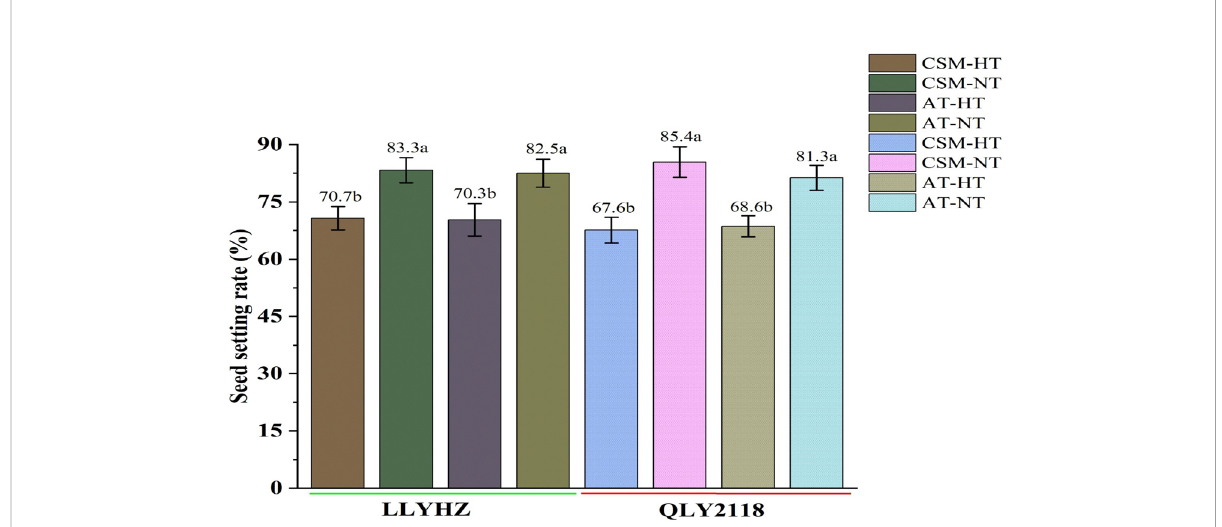
FIGURE 3 Effect of high temperature on seed set of two rice cultivars under different planting methods. Bars with different lowercase letters indicate a signi fi cant difference (LSD test, p < 0.05). Error bars indicate the SD of three biological replicates. LLYHZ, Longliangyou Huazhan; QLY2118, Quanliangyou 2118; CSM, carpet seedling mechanical transplantation; AT, manual transplanting; HT, high temperature; NT, normal temperature.